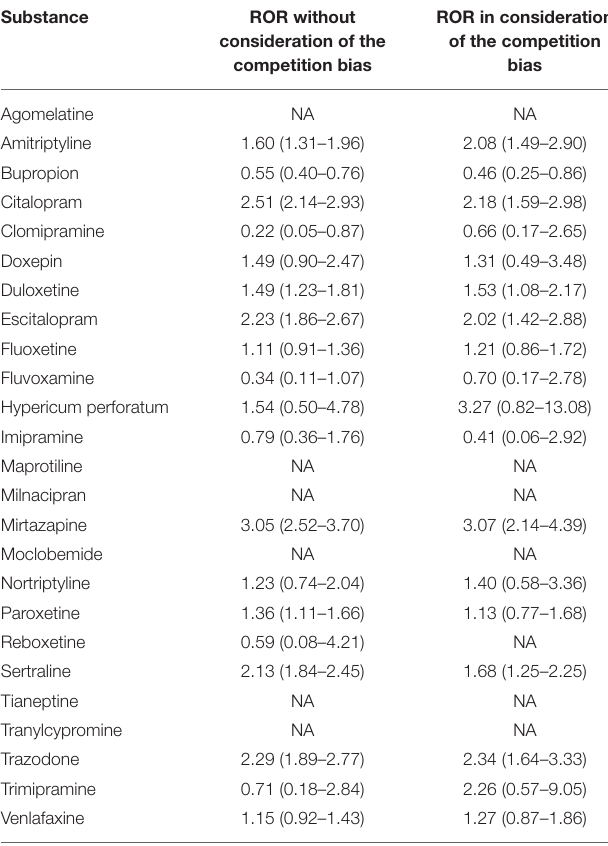
TABLE 2 | Reporting odds ratios and 95% CIs related to antidepressants and the SMQ “Gastrointestinal Haemorrhage” with and without consideration of the competition bias.